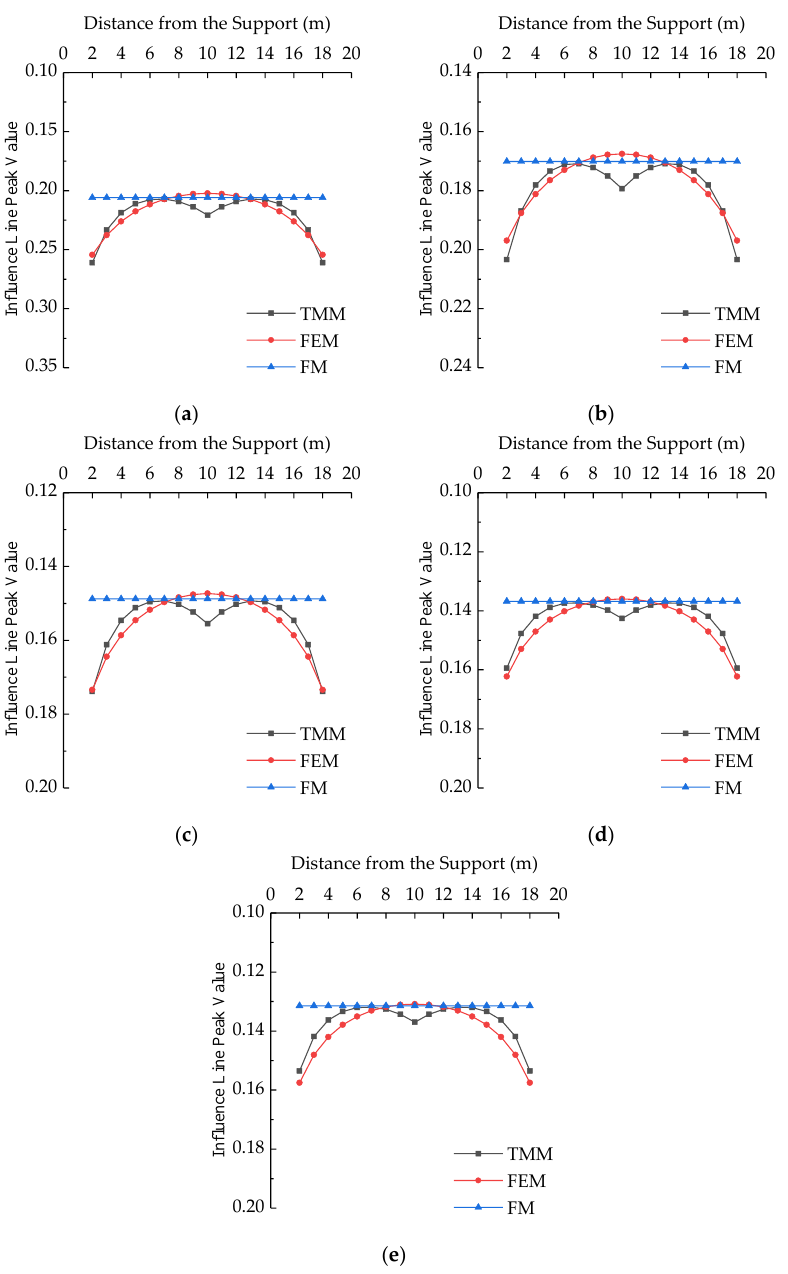
Figure 12. The influence line peak values of TLD for each slab along the span: ( a ) slab 1; ( b ) slab 2; ( c ) slab 3; ( d ) slab 4; ( e ) slab 5.